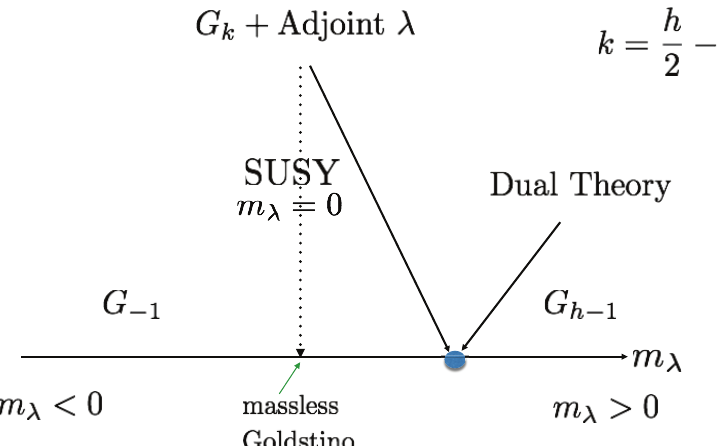
Figure 2: The proposed phase diagram for G = SU ( N ) , SO ( N ) , and Sp ( N ) with − 1. For low values of N the situations can be different. For example, for k = h 2 SU ( 2 ) the transition point occurs at the supersymmetric point m λ = 0. And other 0 than the massless Goldstino there, the TQFT does not change because of the duality ↔ SU ( 2 ) SU ( 2 ) − (as spin-TQFT). Below we will discuss another dual theory that 1 1 flows to the same transition. It is denoted in the figure as “Dual Theory.” The general structure of the figure is as explained in the caption of fig. 1, except that here super- symmetry is broken for m λ = 0 and we also suggest a dual theory of the transition